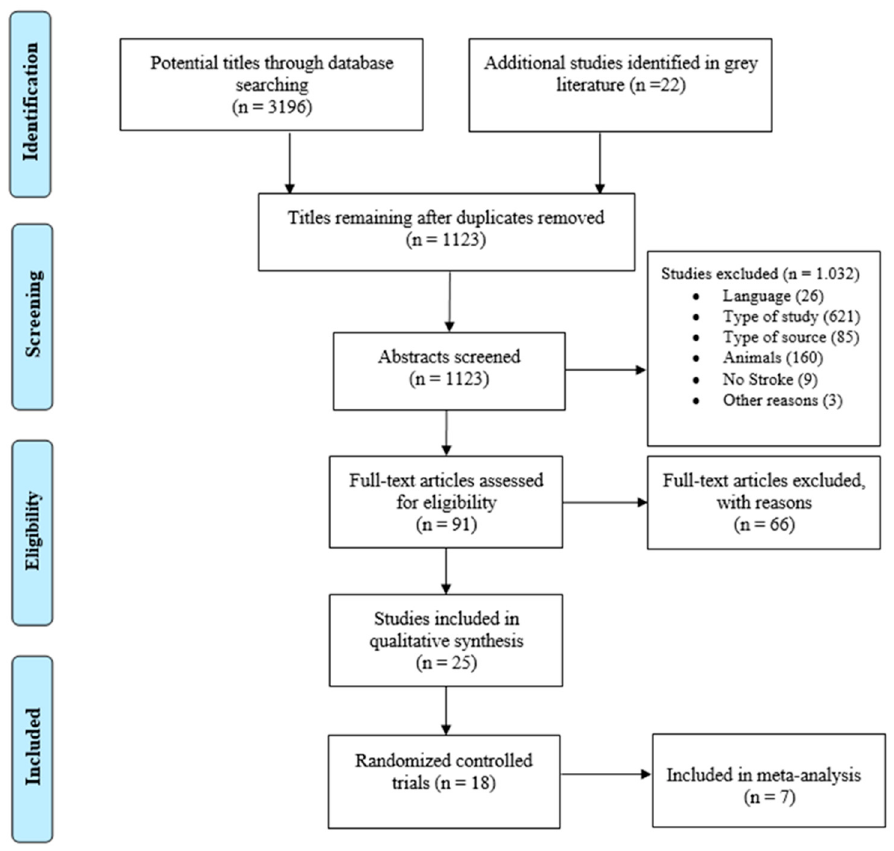
Figure 1. PRISMA diagram of the process used to identify studies.